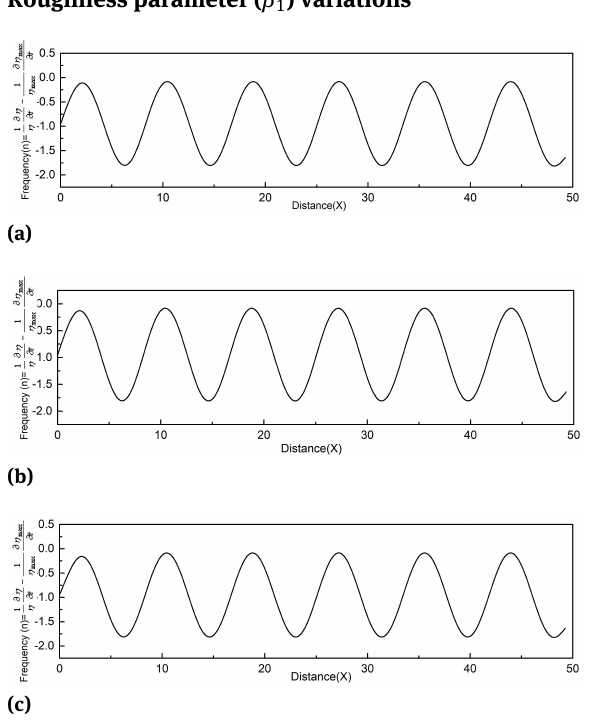
Fig. 2: Shape of interface growth rate shape of interface growth rate for a roughness parameter β −3 , 3.3 × 10 −2 with fixed 1 = 0, 3.3 × 10 values of M =0.3,B =0.02 and β = 2 . ( from top to 0